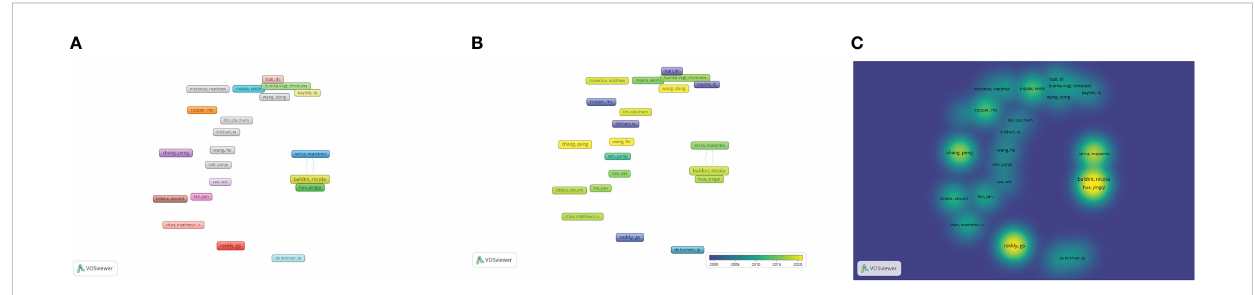
FIGURE 4 Collaboration chart of authors in the fi eld (they have published more than 3 studies in the fi eld). (A-C) are the connection network among authors, the graph of authors ’ hotness over time, and the graph of authors ’ density, respectively.